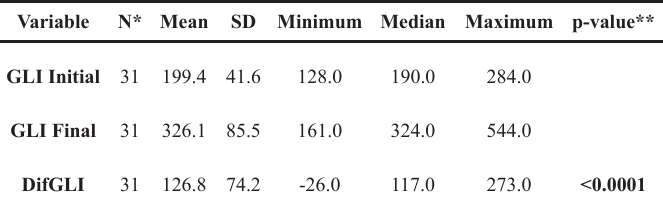
TABLE 3 - Descriptive analysis and initial and end glucose blood